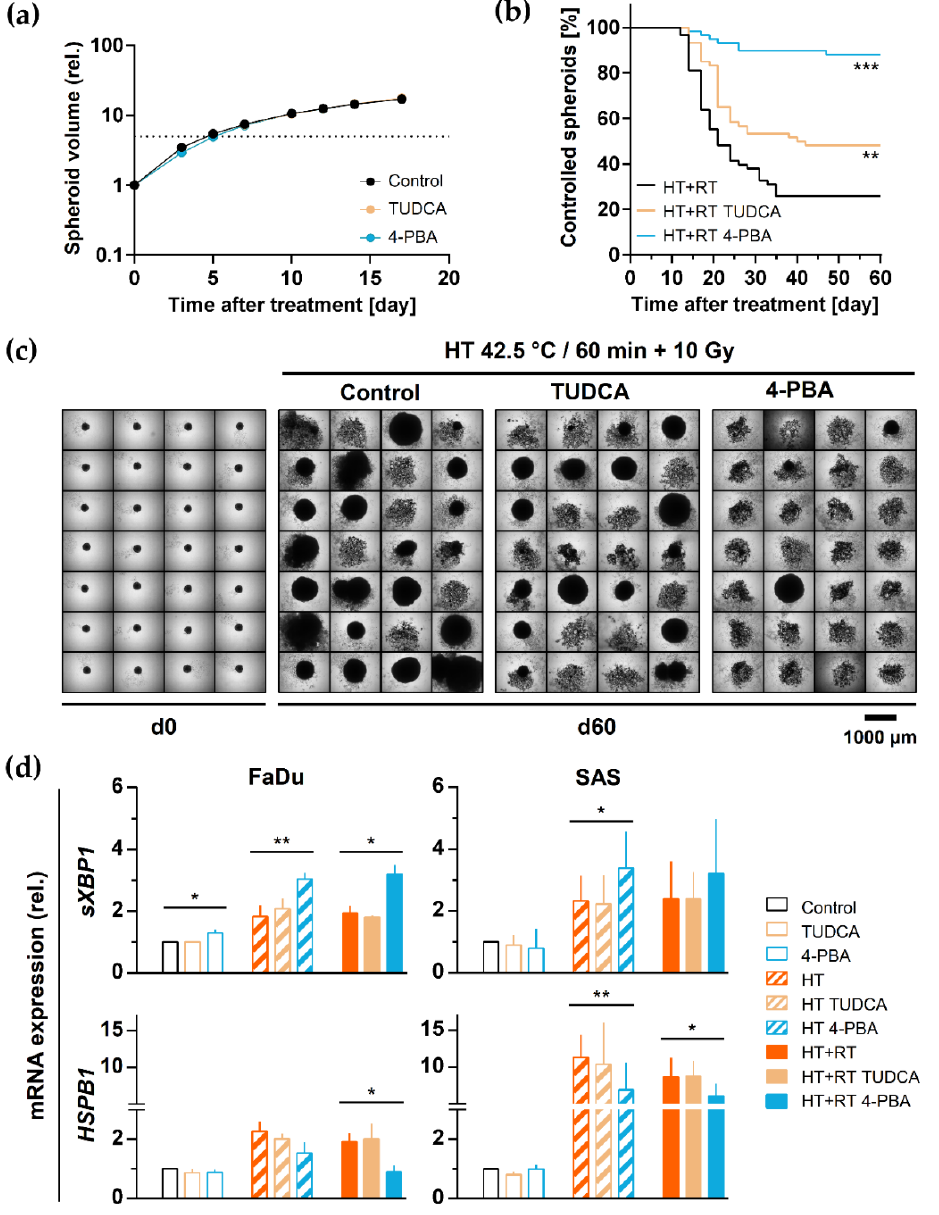
Figure 5. Induction of proteotoxic stress plays a protective role in HNSCC spheroids against HT-induced radiosensitization: ( a ) 24 h treatment with the chemical chaperones TUDCA (0.4 mM) and 4-PBA (5 mM) alone does not affect SAS spheroid volume growth kinetics. Data points show mean spheroid volumes of ∑ n ≥ 56 spheroids per treatment arm from N = 2 independent experiments ( ± SD). ( b ) Proportion of controlled SAS spheroids irradiated with 10 Gy directly after exposure to 42.5 ◦ C for 60 min in the absence or presence of TUDCA (0.4 mM) or 4-PBA (5 mM); the time courses represent the monitoring of ∑ n ≥ 56 spheroids per treatment arm from N = 2 independent experiments over a period of 60 days post- treatment. ** p < 0.01 and *** p < 0.001 as assessed with the Log-rank (Mantel-Cox) test for survival curves based on the pooled data. ( c ) Images of 28 representative SAS spheroids before and at day 60 after treatment with HT + RT with or without TUDCA or 4-PBA according to ( b ). ( d ) qPCR analysis of sXBP1 and HSPB1 gene expression 0.5 h after HT (42 ◦ C, 60 min) with or without RT (7 Gy—FaDu, 10 Gy—SAS) in the absence and presence of TUDCA or 4-PBA according to ( b , c ); data were normalized to ACTB gene expression and are shown as means (+SD) of N = 3 independent experiments; * p < 0.05; ** p <